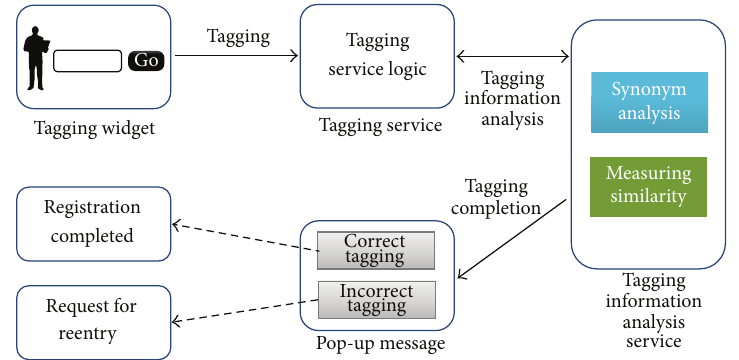
Figure 2: Process of tag